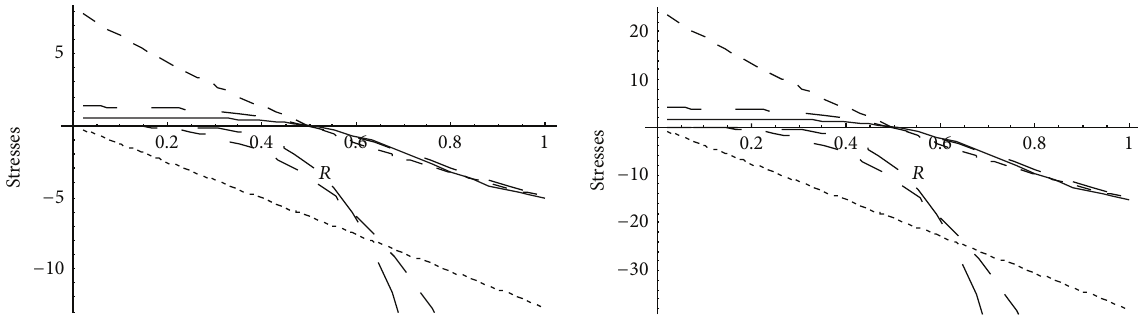
Figure 6: Nonhomogeneous transitional stresses for a thick-walled circular cylinder under external pressure ( 𝑃 2 = 5 and